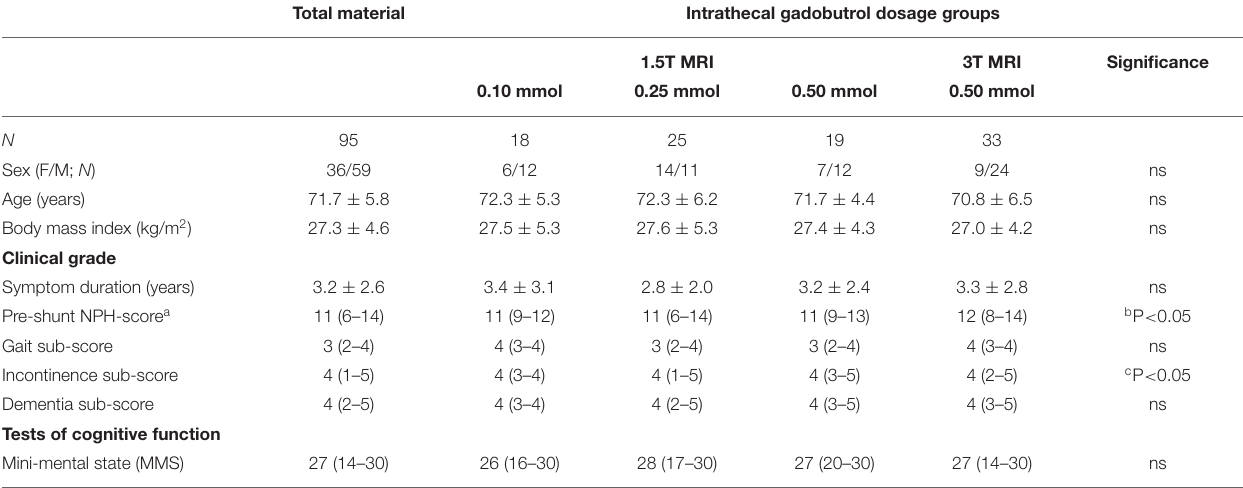
TABLE 1 | Demographic and clinical information about the different treatment